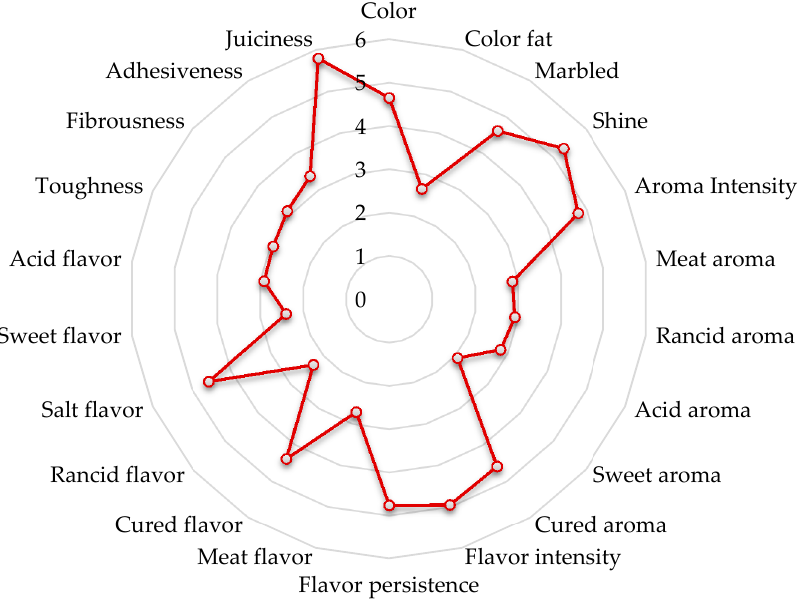
Figure 2. Sensory attributes of dry-cured Bísaro shoulder.